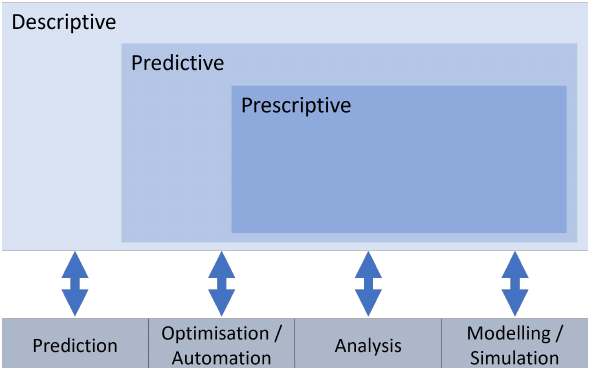
Figure 10. Synthesis of EXplainable Artificial Intelligence (XAI) conceptual